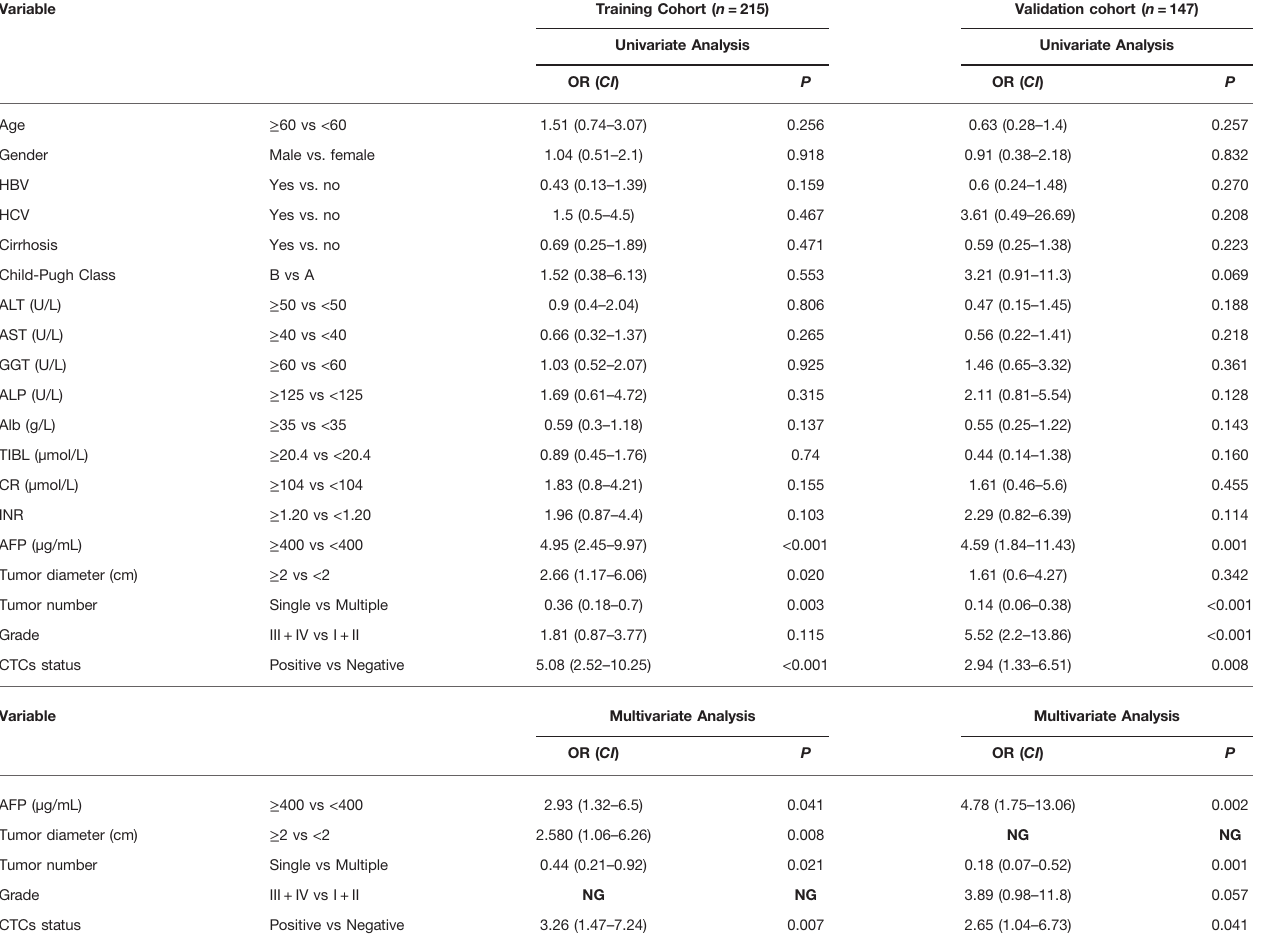
TABLE 6 | Univariate and multivariate analysis to predict independent risk factors for microvascular